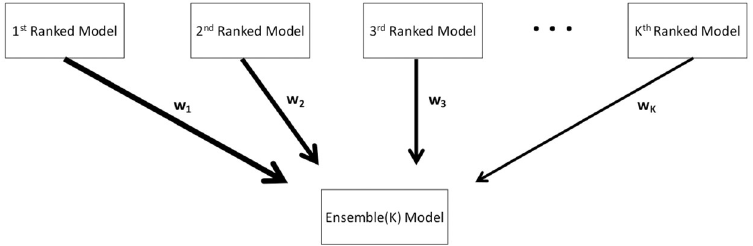
Fig 9. Schematic diagram of the construction of the ensemble model from the weighted combination of the highest-ranking sub-epidemic models as deemed by the AIC i = 1, ... , I . An ensemble derived from the top-ranking I models is denoted by Ensemble(I).